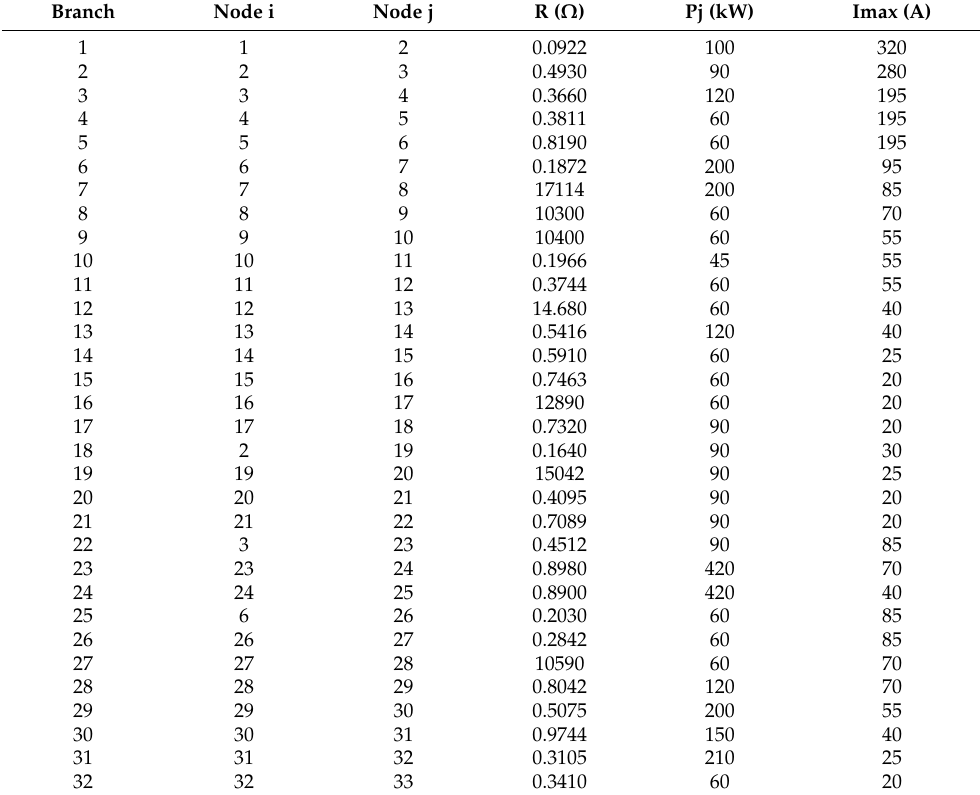
Table 2. Electrical parameters of the IEEE 33-bus